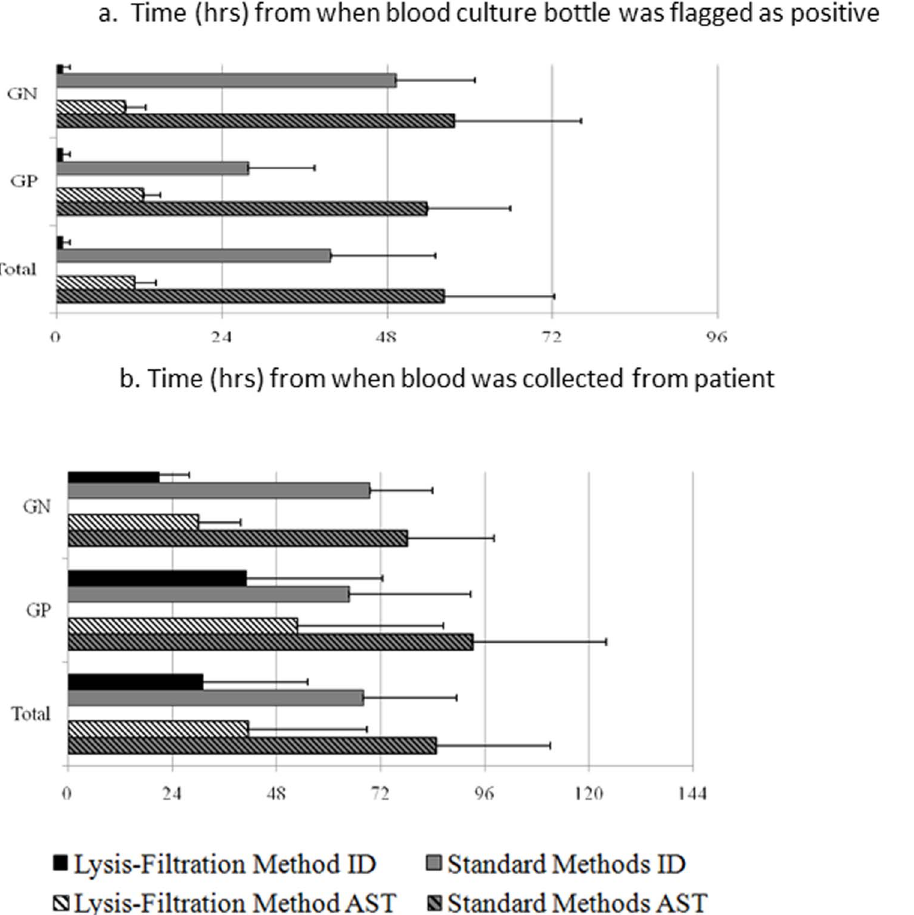
Figure 2. Average time in hours to results of ID or AST from (a) time when blood culture bottle was flagged as positive or (b) time when blood was collected from patient. For the Lysis-Filtration Method, ID was performed using VITEK MS, AST was performed using VITEK H 2. AST=antimicrobial susceptibility testing. GN=Gram-negative organisms; GP=Gram-positive organisms; ID=identification; VITEK MS=MALDI-TOF VITEK MS RUO.